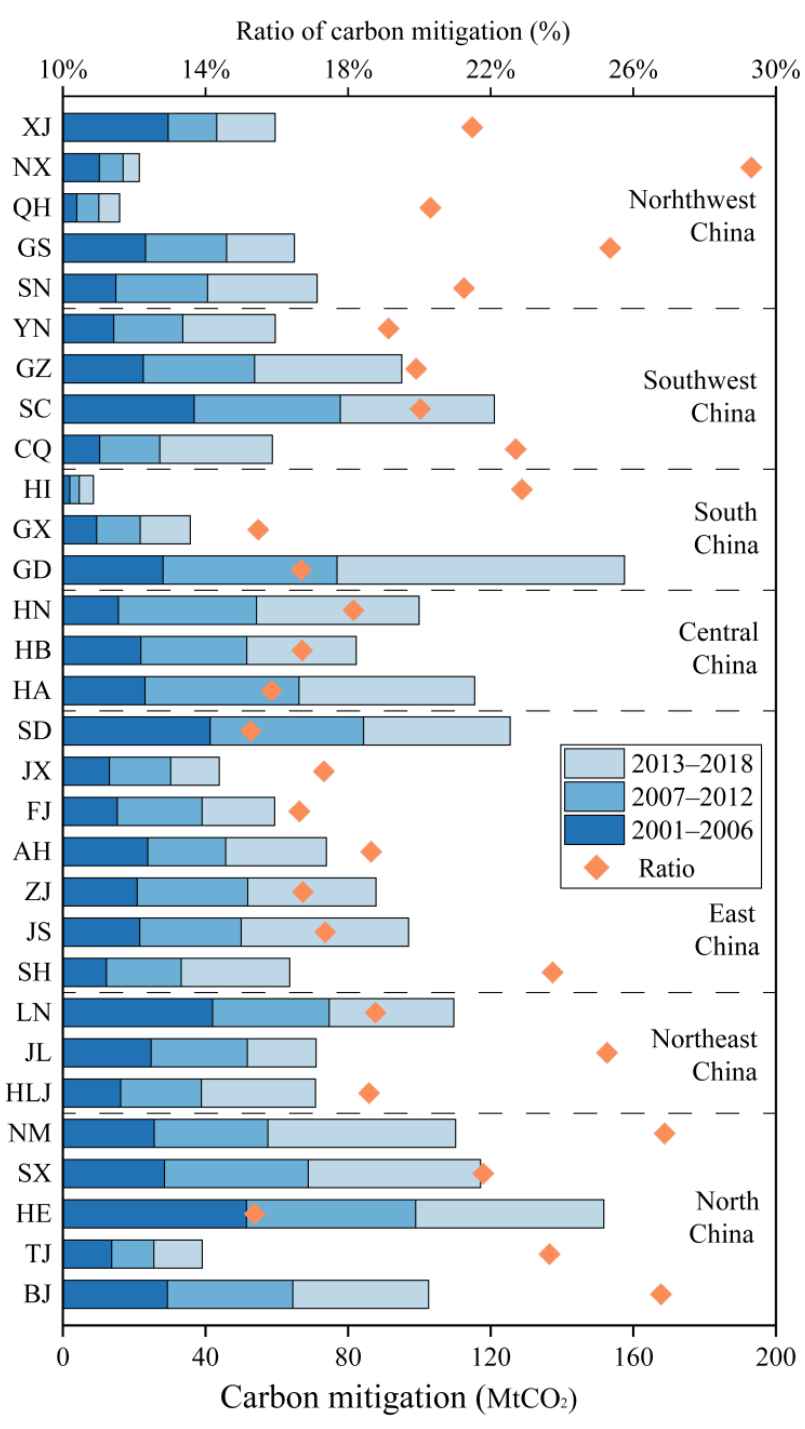
Figure 4. Total carbon mitigations and carbon mitigation efficiency of residential buildings in each province (2001–2018). Note: Abbreviations of province names and region divisions are detailed in Appendix